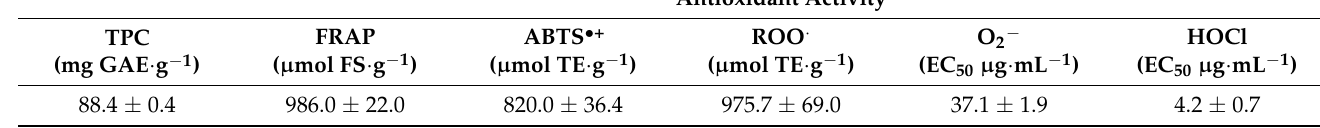
Table 2. The antioxidant capacity of the optimized aça í meal extract as determined by the total pheno- lic content (TPC), ferric-reducing antioxidant power (FRAP), and scavenging of ABTS radical cation (ABTS • + ), and ROS assays [peroxyl radical (ROO • ), superoxide anion (O 2 •− ), and hypochlorous acid